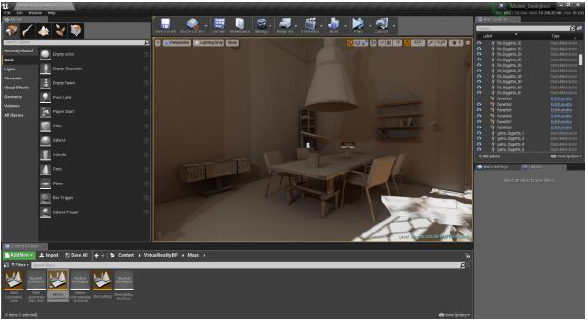
Figure 5. Virtual simulation development in Unreal Engine.